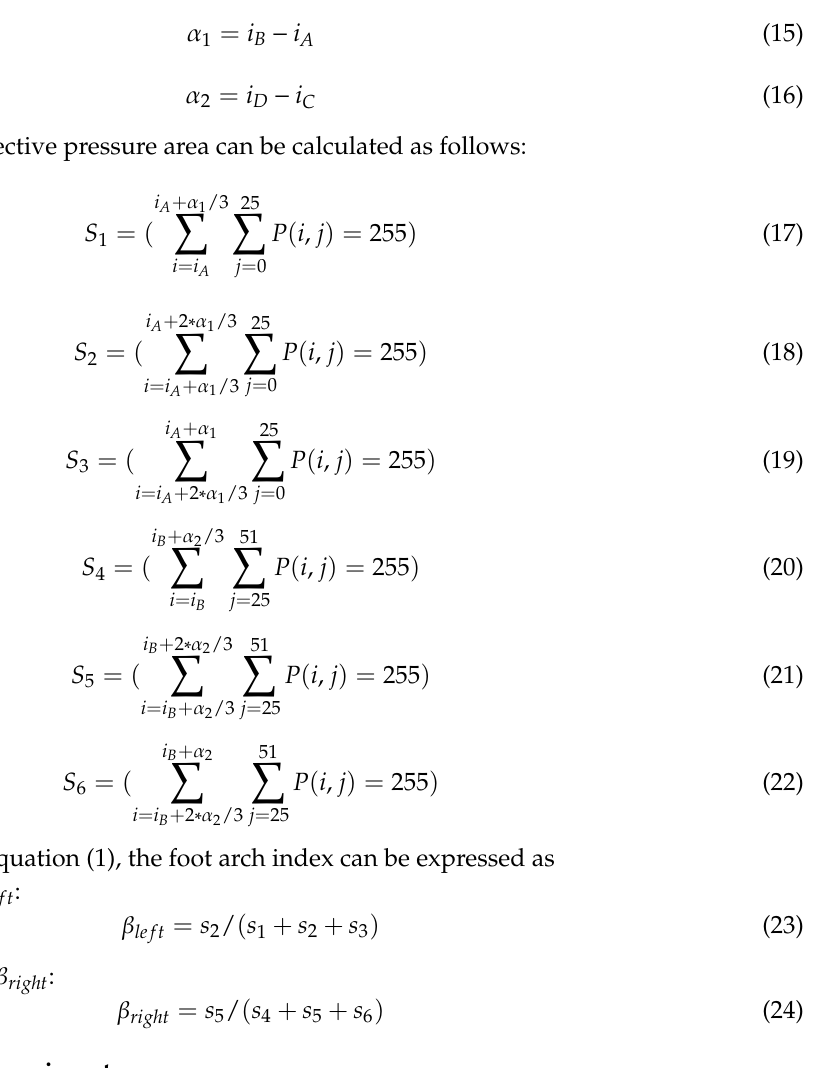
Figure 7. Endpoints of the left and right soles.